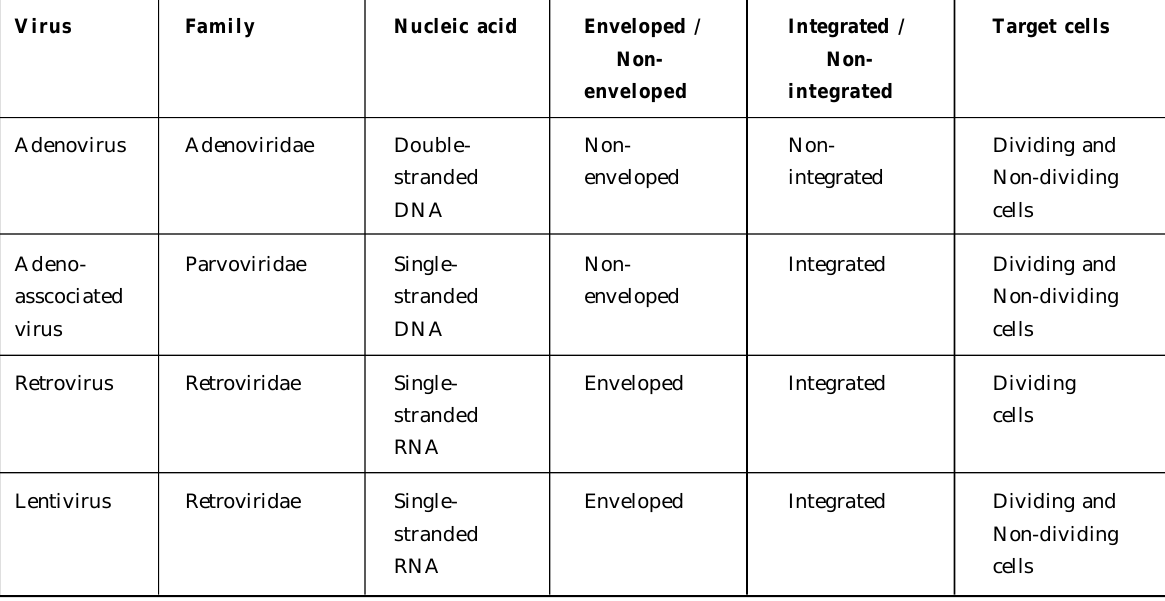
Table 1: The most commonly used viral vectors in gene therapy Virus